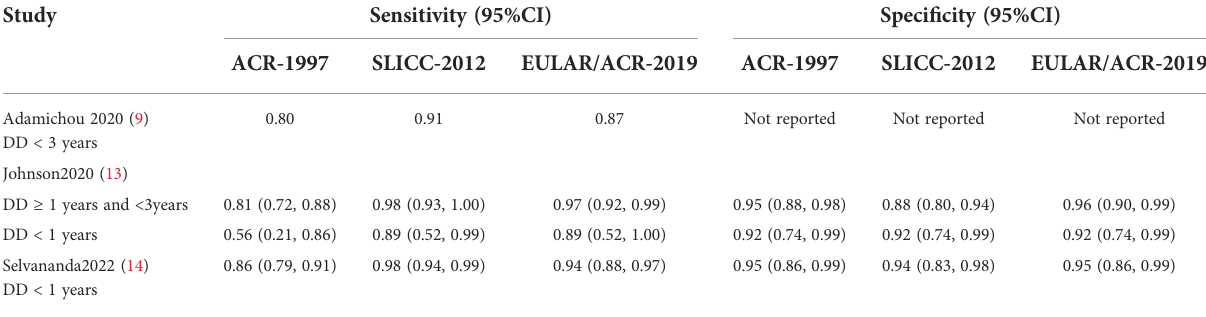
TABLE 3 Diagnostic ability of ACR-1997, SLICC-2012, and EULAR/ACR-2019 classi fi cation criteria in patients with early SLE.